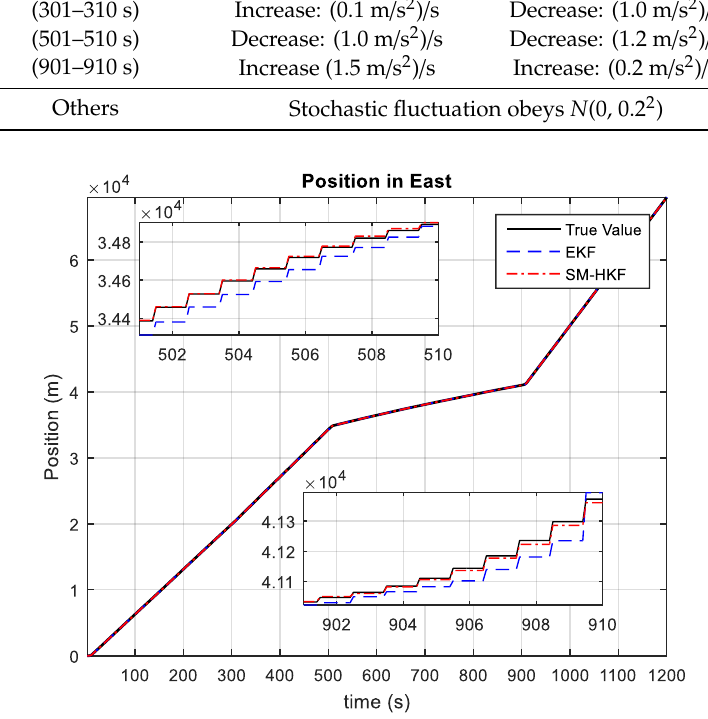
Figure 3. The positions in East estimated by EKF and SM-HKF.